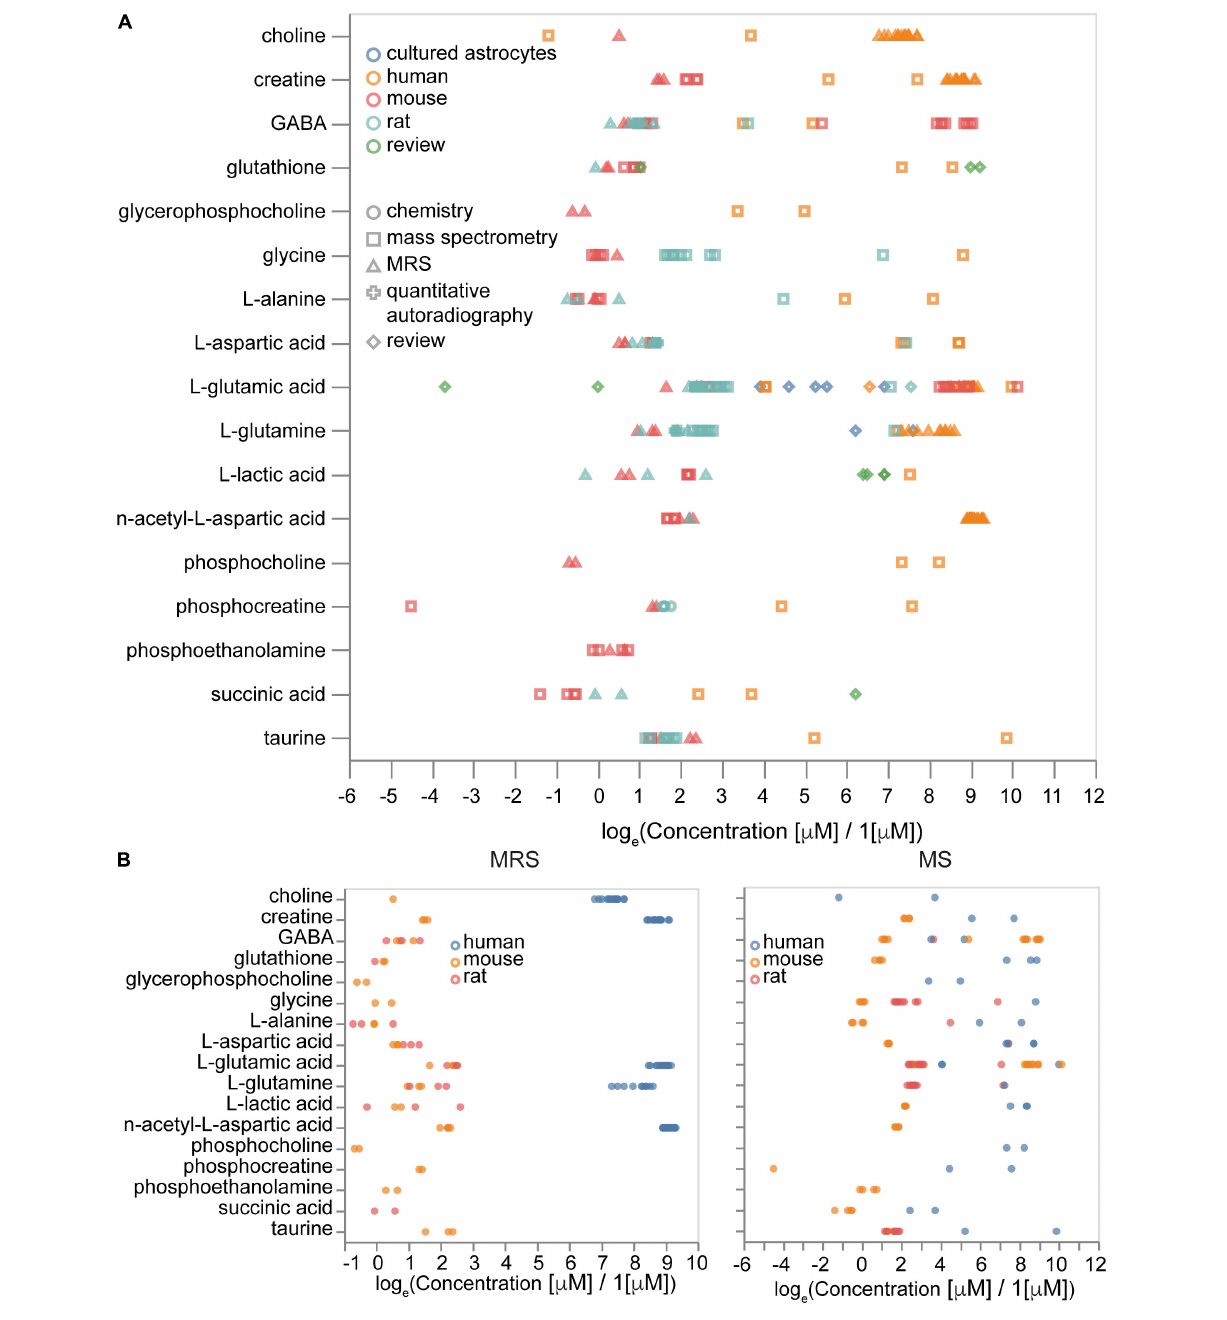
FIGURE 9 | Sources of variability in metabolite concentrations. (A) Effects of measurement methods and species on the concentrations of metabolites. (B) Concentrations of molecules measured by magnetic resonance spectroscopy (MRS, left) and by mass-spectrometry (MS, right) with the same set of molecules measured by both MRS and MS. Sample sizes are available from the Supplementary Presentation